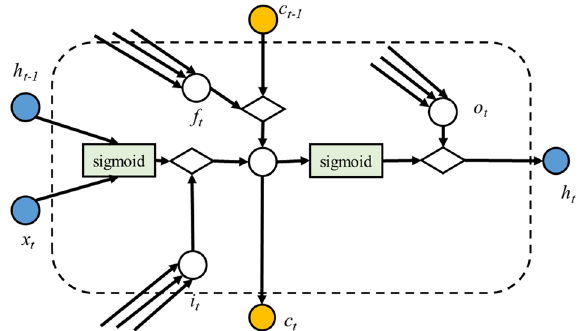
Figure 2. Structure of the long- and short-term memory neural network